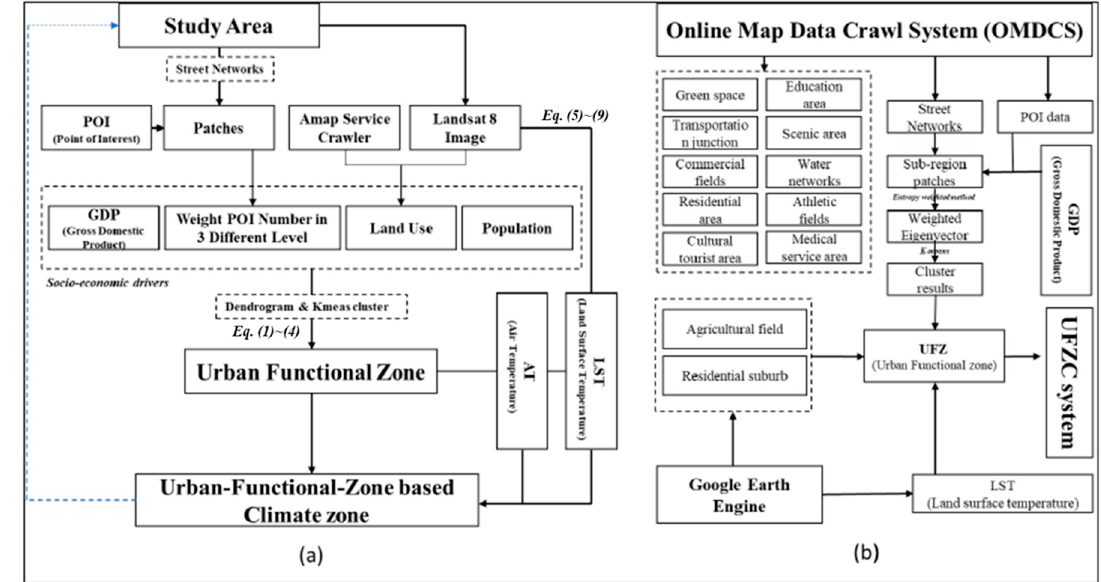
Figure 1. The technical framework of urban functional zone-based urban temperature (UFZC) system identification. ( a ) is the general technical framework of UFZC system identification; ( b ) is the specific technical process to obtain the UFZ and UFZC system. UFZC